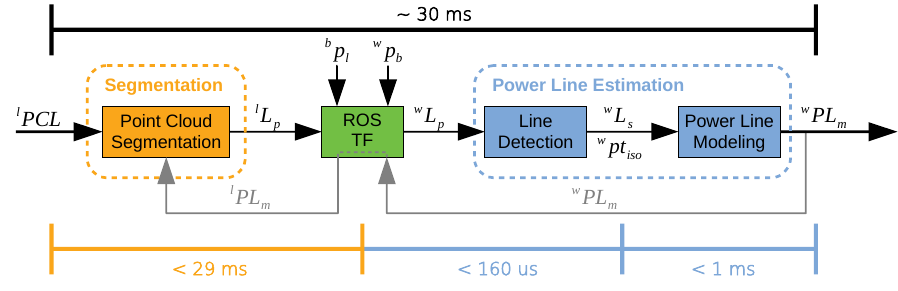
Figure 23. Total processing times of the PL 2